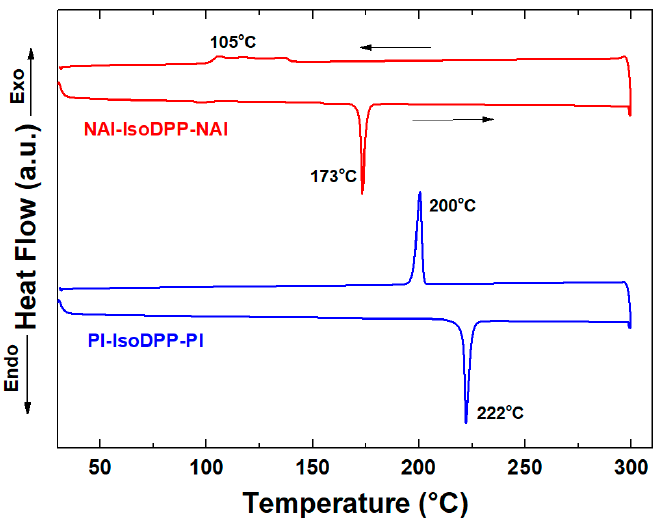
Figure 2. Differential scanning calorimetric (DSC) traces (second scan) of NAI-IsoDPP-NAI and PI-IsoDPP-PI. Note the first scan in each case was similar.